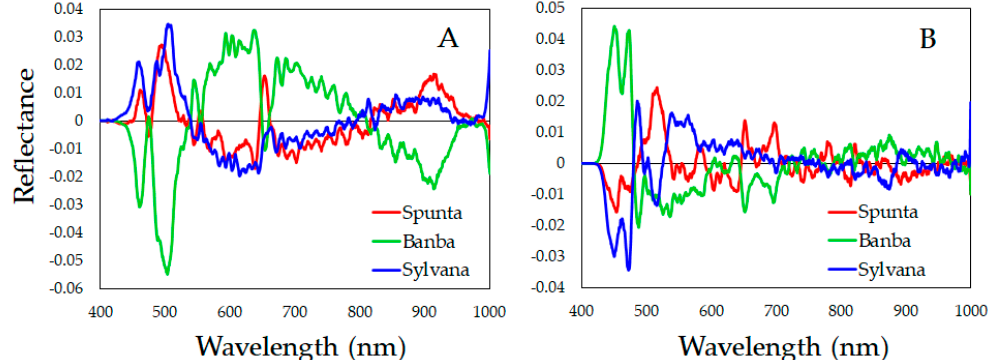
Figure 6. Spectra reflectance data upon pre-processing (normalization, Savitzky–Golay first derivative and mean centering) that were externally captured from 3 commercial potato cultivars (Spunta, Banba, and Sylvana) during storage for 0, 2.5, or 5 months at 5 °C externally on the skin ( A ) or internally in the flesh ( B ) of the tubers. In each cultivar, the data were pooled from the samples stored for 0, 2.5, or 5 months at 5 °C.